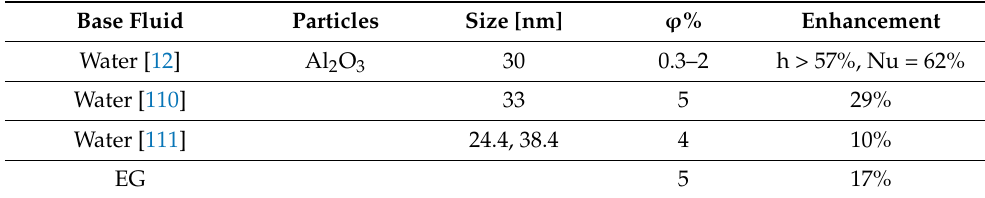
Table 1. Heat transfer enhancement using different